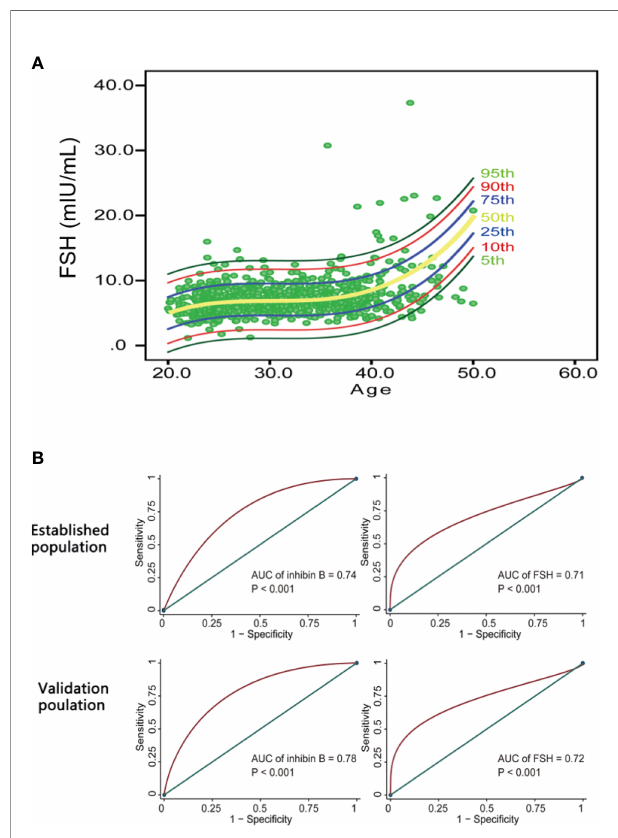
FIGURE 5 | The potency of inhibin B and FSH in predicting AFC<5-7. (A) FSH nomogram based on cubic regression model. Each line represents the value of con fi dential interval (CI). Rapid increase of FSH value was observed in women after 40 years old. (B) ROC curves evaluating the diagnostic value of inhibin B and FSH in predicting AFC < 5-7. Inhibin B (AUC = 0.74, P < 0.001 for the establishment population; AUC = 0.78, P < 0.001 for the validation population) had a slightly higher value than FSH (AUC = 0.71, P < 0.001 for the establishment population; AUC = 0.72, P < 0.001 for the validation population) in diagnosing